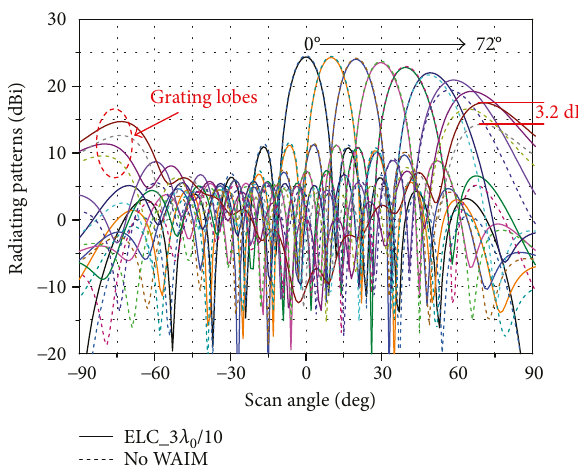
Figure 8: Simulated scan beams from 0 ° to 72 ° at 10.0GHz in two cases: without WAIM and with ELC metasurface slabs of 3 λ /10 height. 0